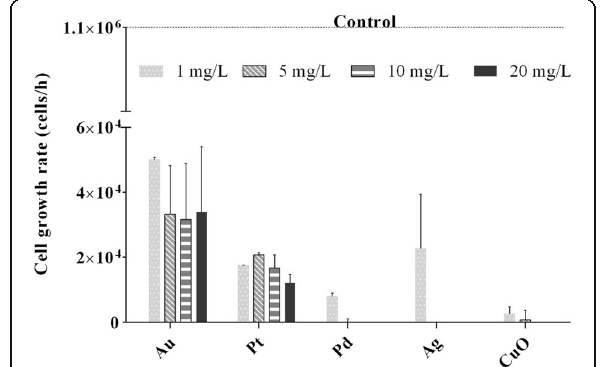
Fig. 2 Growth rate of Chlamydomonas reinhardtii exposed to Au, Pt, Pd, Ag and CuO metal and metal oxide nanoparticles (1, 5, 10 and 20 mg/L). The growth rate for the non-exposed control (algal culture) was 1×10 6 cells/h after 24 h. The error bars represent the standard deviation of repeated experiments using duplicate